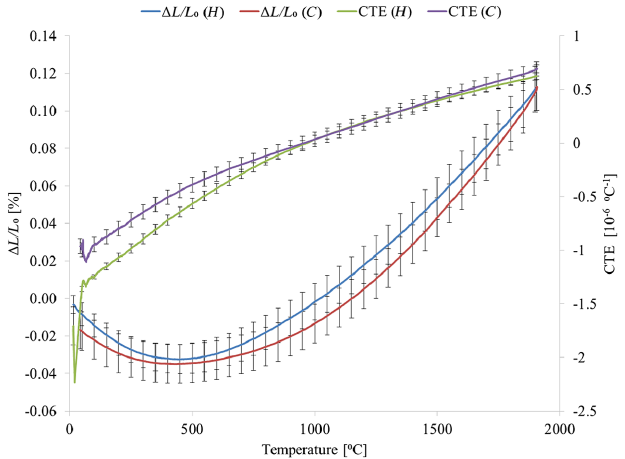
FIG. 13. Relative change in length and CTE against temper- ature with initial thermal reference of 42 . 7 °C ( H ) and 50 . 03 °C ( C ) for CFC along ( L ).